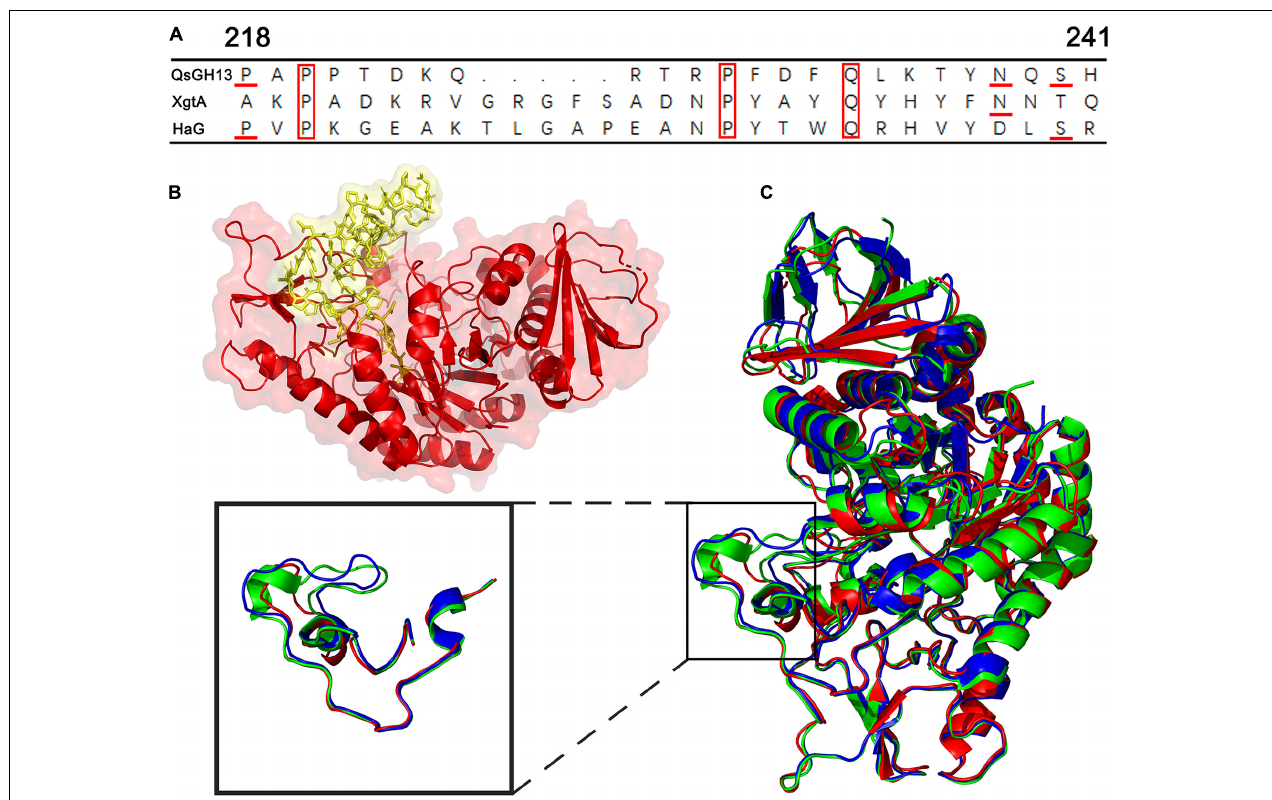
FIGURE 5 | The β → α loop 4 of QsGH13 in comparison with other proteins. (A) Superposition of amino acid residues of QsGH13 with amino acid residues of other proteins in the β → α loop 4; the red box represents the conserved amino acid residue. (B) Sticks represent the β → α loop 4 of QsGH13. (C) The monomer structure comparison of QsGH13 (red), XgtA (green), and HaG (blue). The blue box represents the β → α loop 4 domain of the protein. The β → α loop 4 domain of the protein; the black box represents the different structures of the three